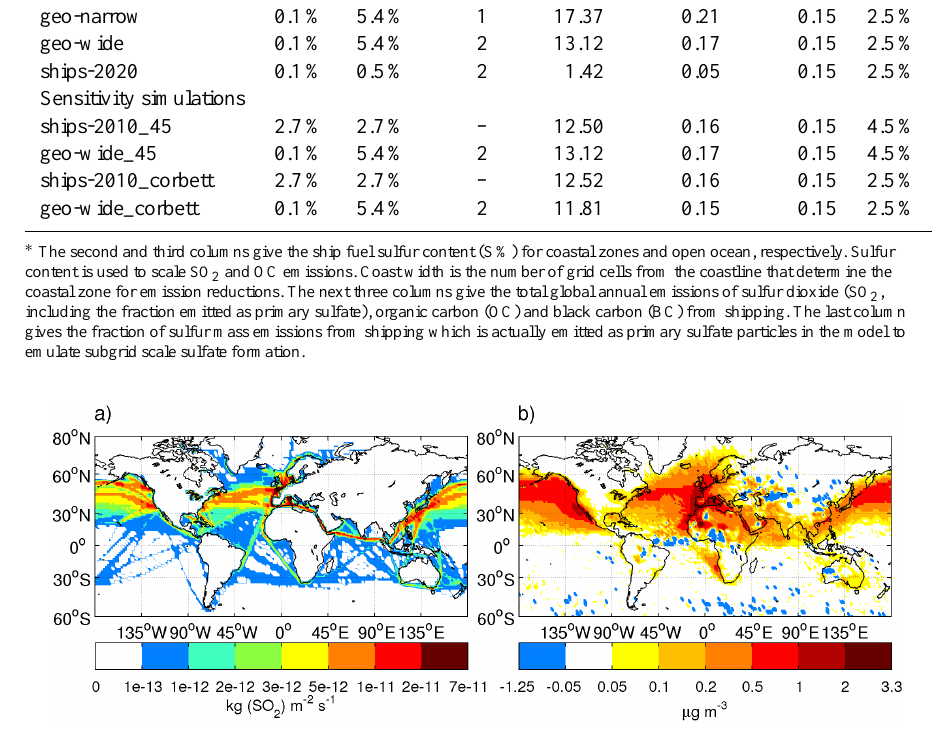
Fig. 1. (a) SO 2 emissions from ship traffic in the simulation ships-2010. The emissions are from the ACCMIP database for the year 2010. (b) The contribution of shipping emissions to PM 2 . 5 mass concentrations in the simulation